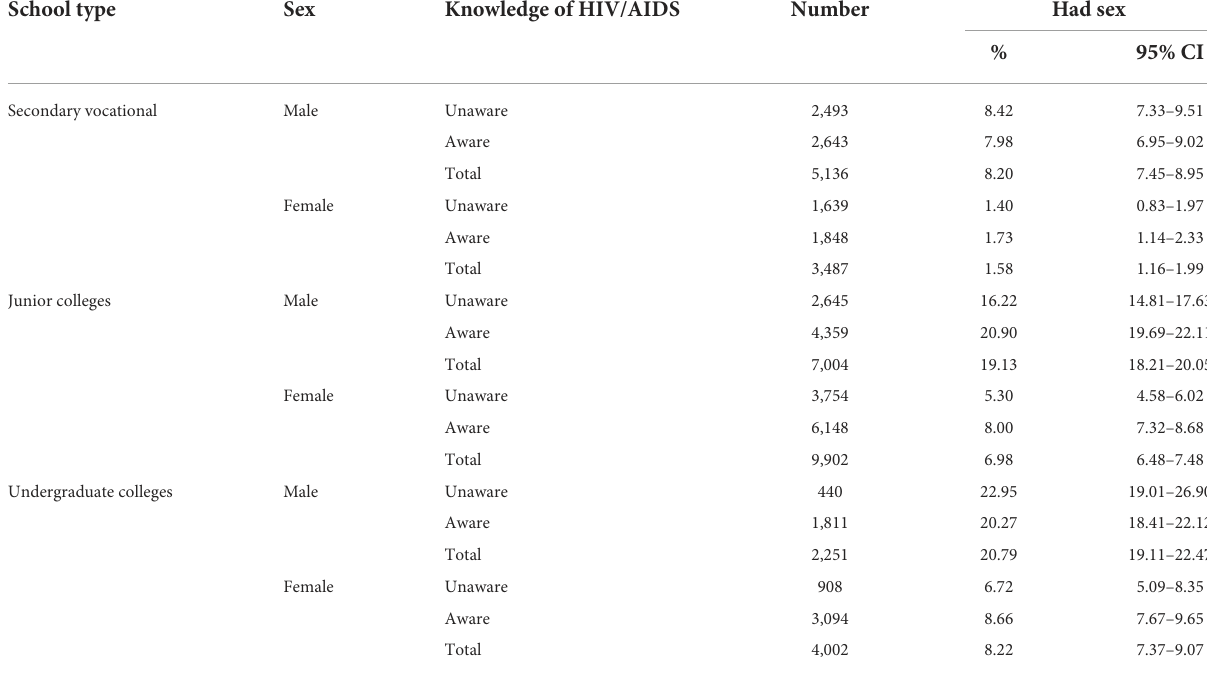
TABLE 7 Sexual behavior of young students ( n = 31,782).